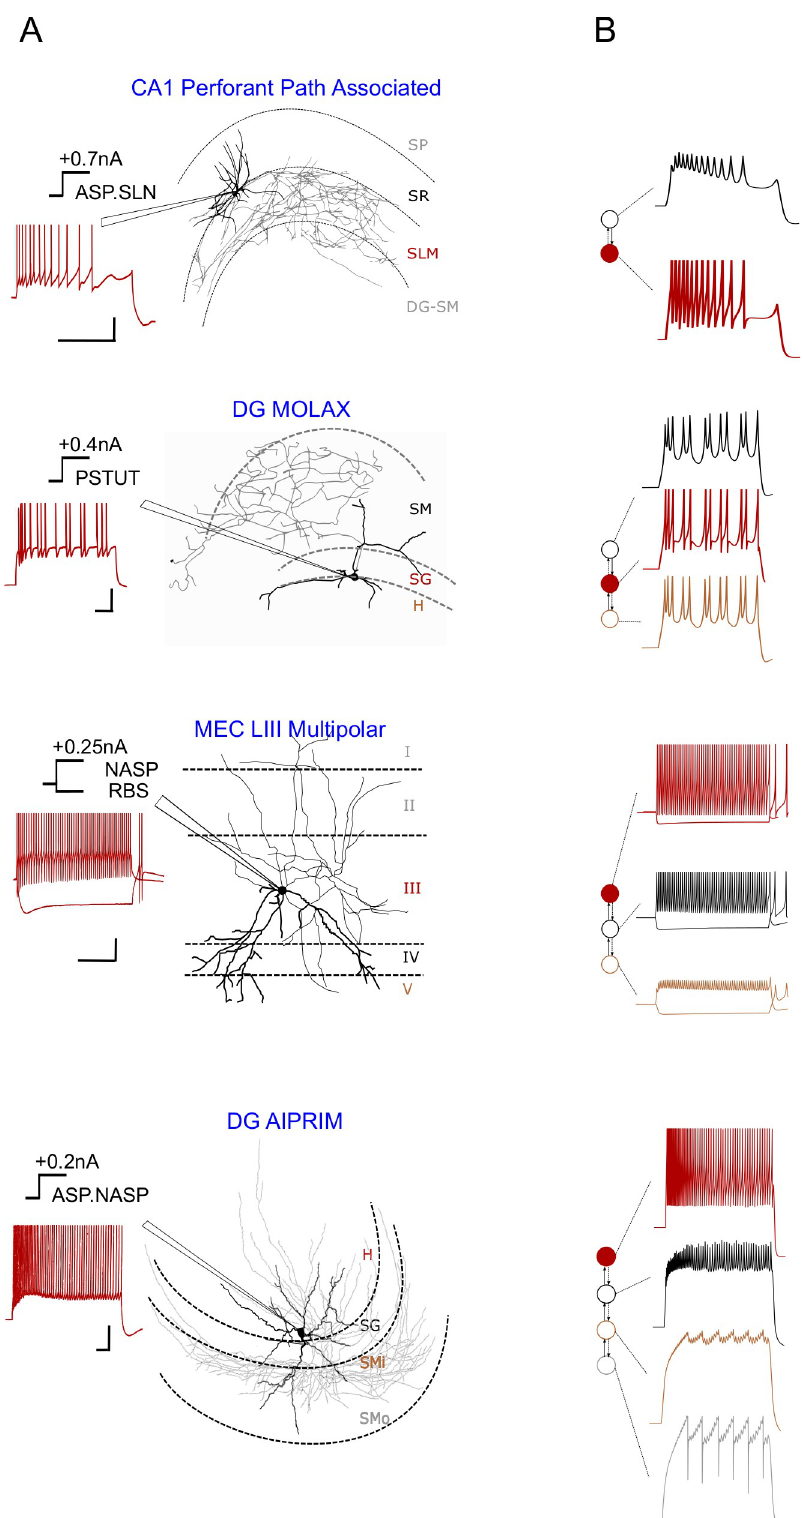
Fig 3. Multi-compartment models compactly extend point neurons to allow layer-level spatial context. ( A ) Experimentally recorded somatic voltage traces (left) are given for four different morphological types (right).